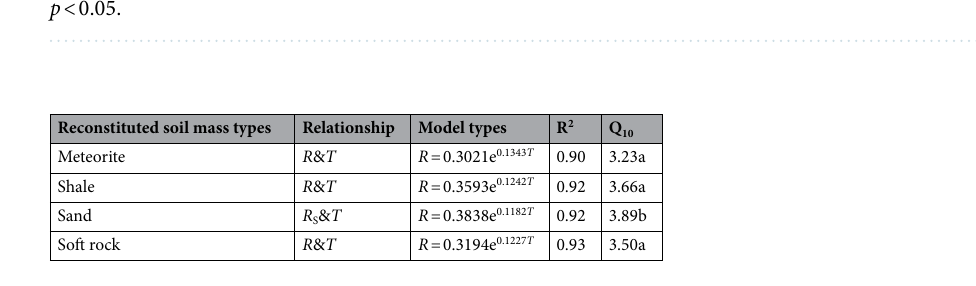
Table 4. Relationship between annual soil respiration (R) rate and temperature